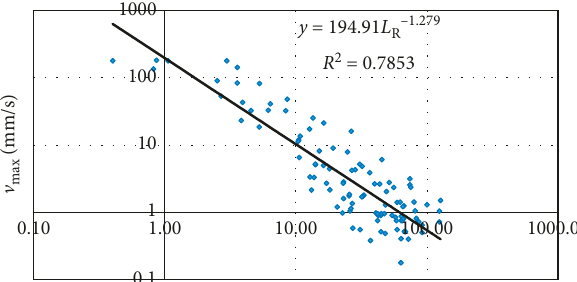
Figure 3: Law of attenuation and regression model from all deposits.